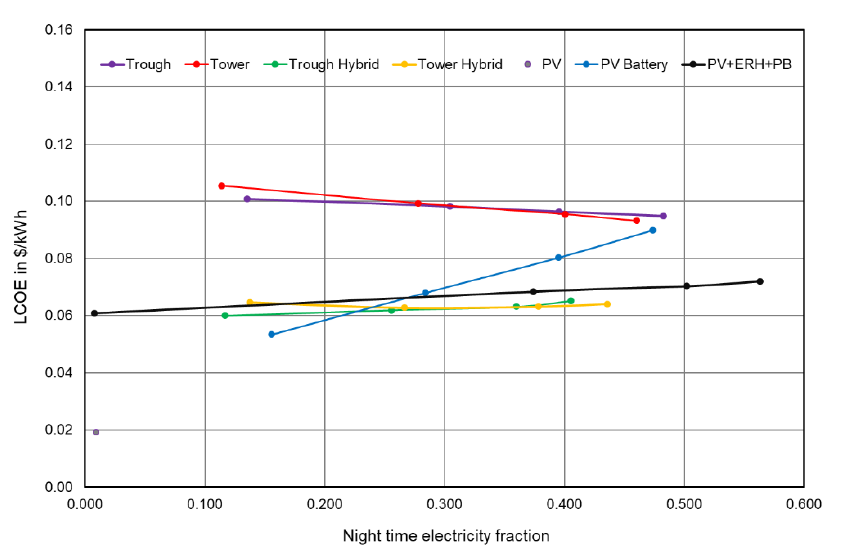
Figure 4. Lowest levelized cost of electricity (LCOE) configurations in Riyadh.